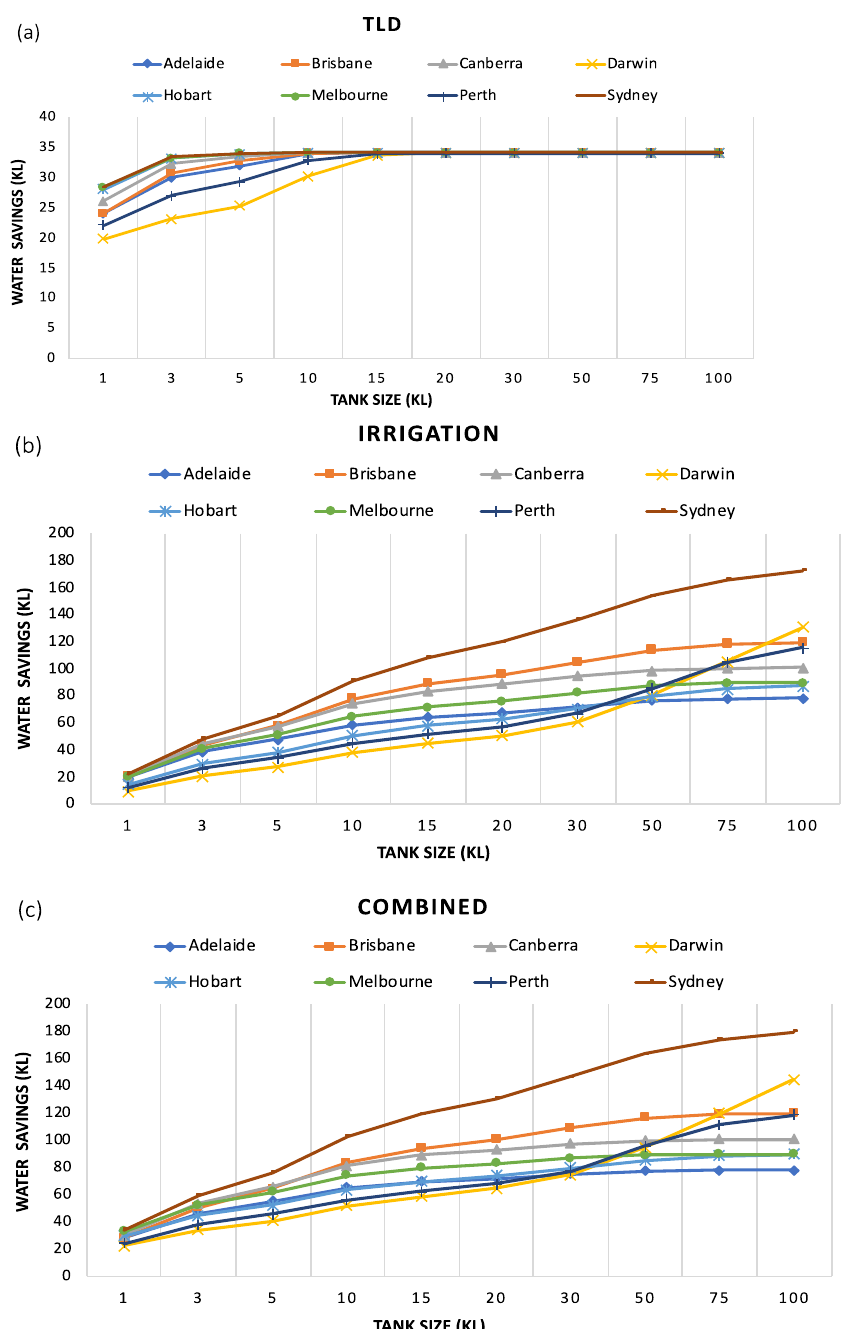
Figure 5. Average annual water savings for TLD, irrigation and combined use ( a ) TLD use; ( b ) irrigation use; ( c ) combined use.